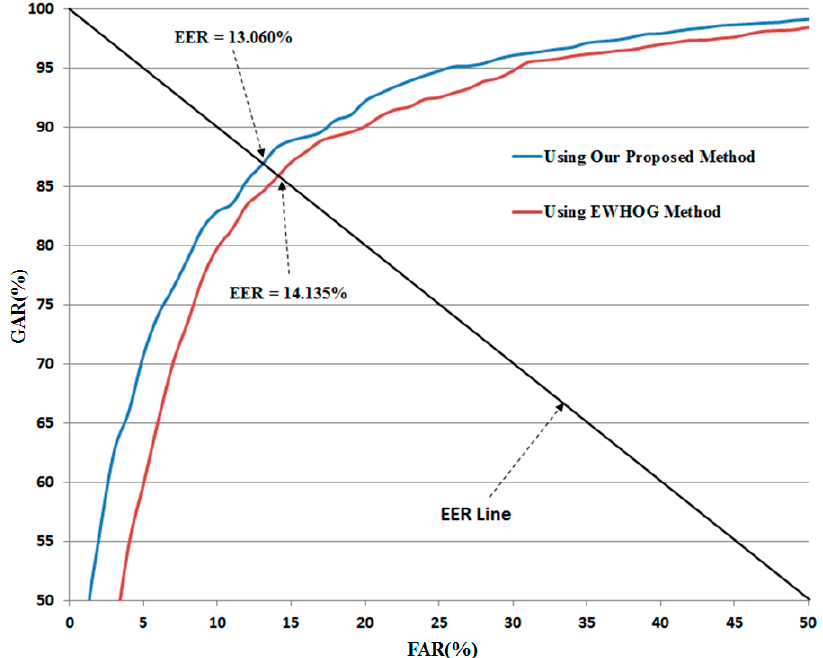
Figure 11. Average ROC curve of our method and EWHOG method for gender recognition.